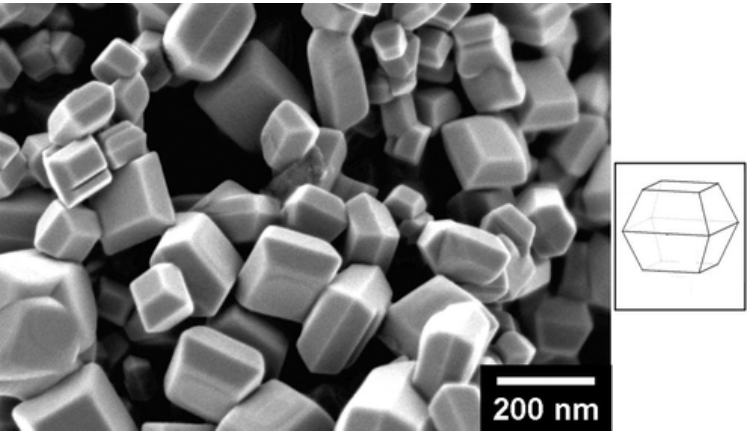
crystals dominated by {001} facets formed by a gas phase Figure 12. Anatase TiO 2 process. Reprinted with permission from ref. [78]. Copyright 2009 American Chemical